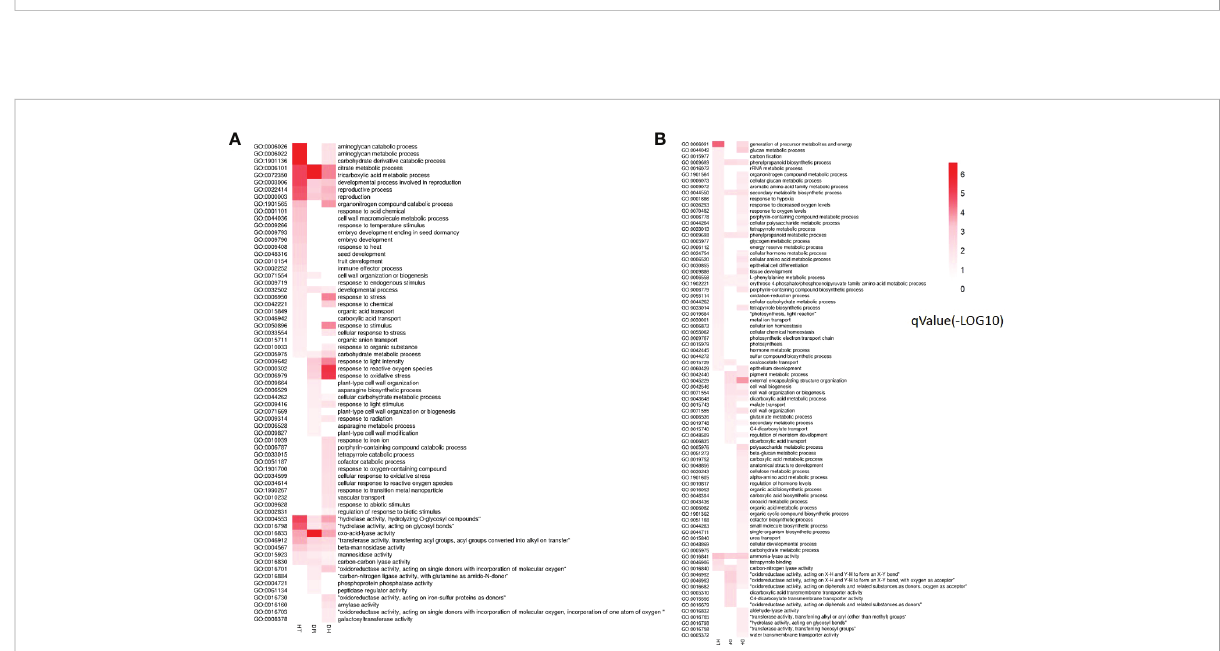
FIGURE 3 Heatmap of the q - values for GO categories showing DEG enrichment under HT, DR and DH stresses compared with CK. (A) Functional enrichment analysis of up-regulated DEGs under HT, DR, and DH stresses. (B) GO terms of down-regulated DEGs under HT, DR, and DH stresses. The color scale ranges from white (no DEGs), light-red (DEGs with low q -values) to red (DEGs with high q -values). HT, heat stress; DR, drought stress; DH, drought and heat